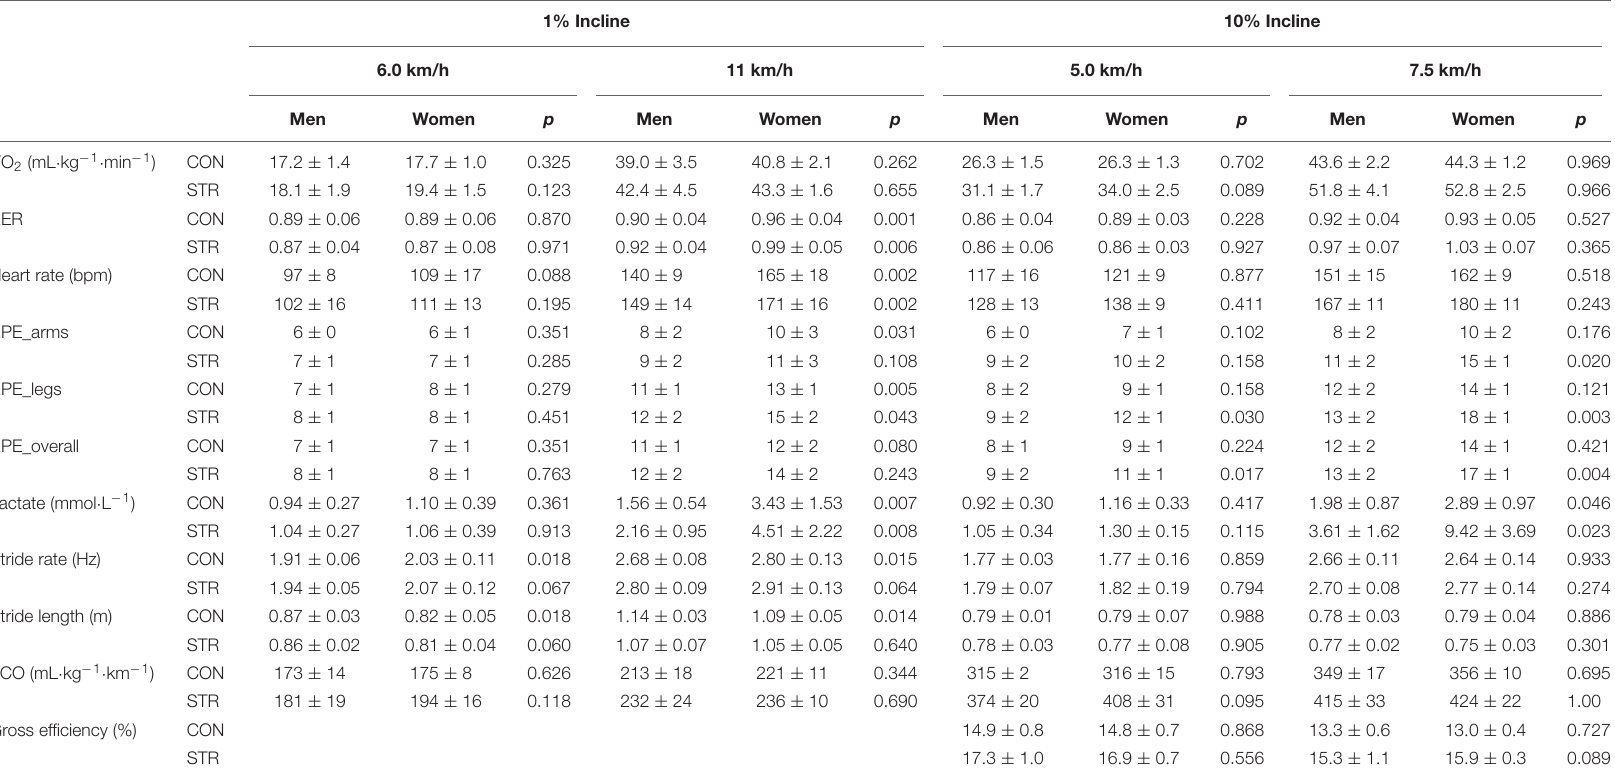
TABLE 4 | Comparison of the physiological and kinematic behavior of men and women while walking or running with or without a